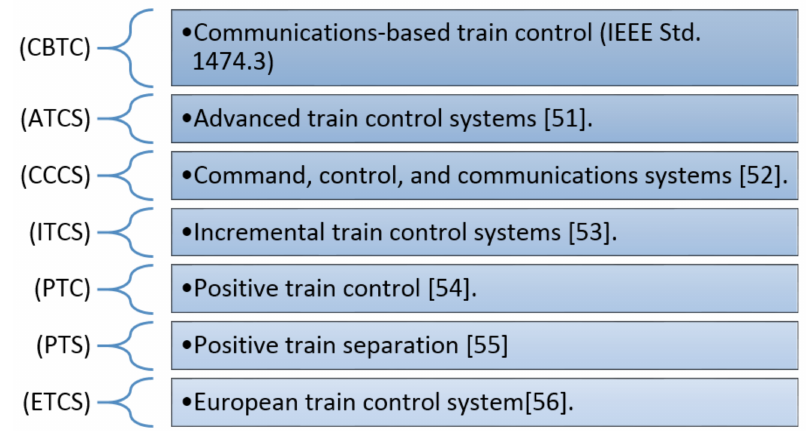
Figure 2. Main communication and signalling systems for train control